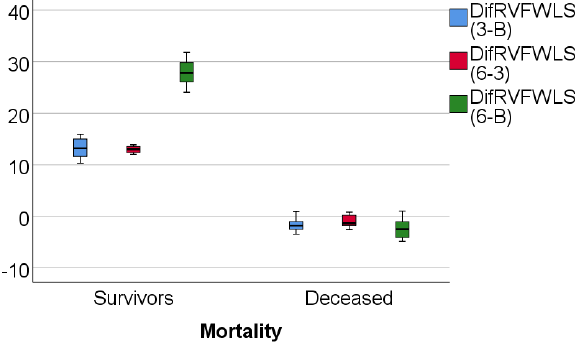
Figure 4. Box-plot representation of RVFWLS evolution in comparison with mortality.